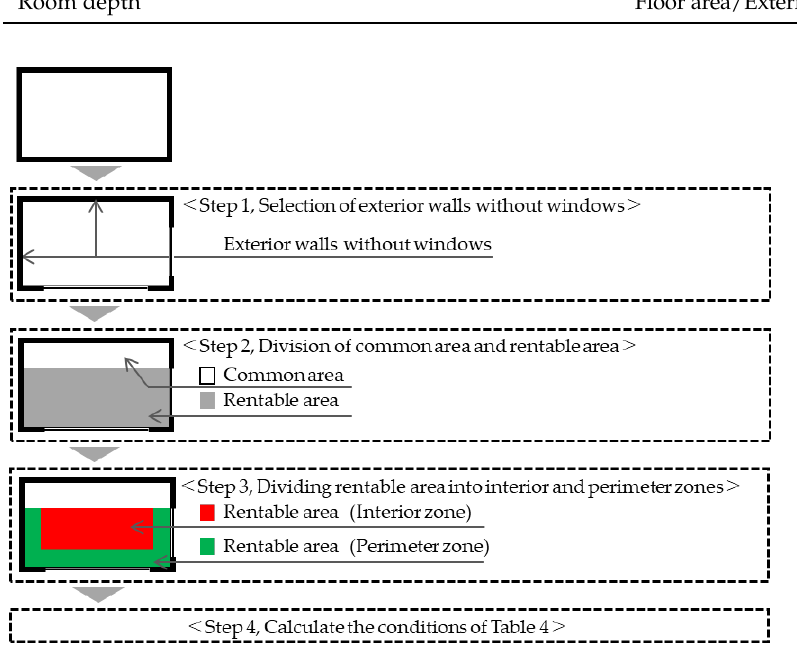
Figure 10. Model creation flow